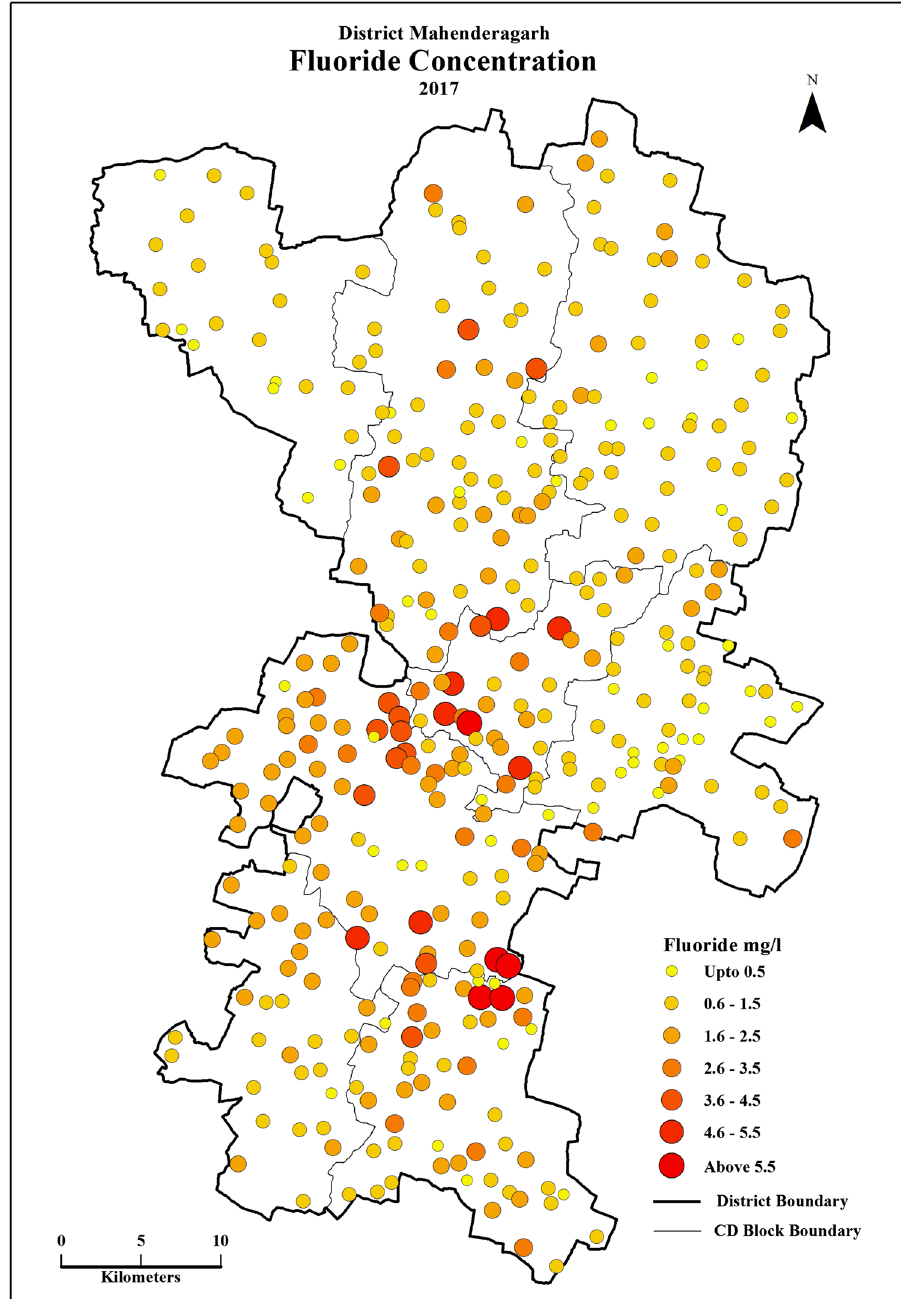
Fig. 2 Fluoride concentration distribution map of district